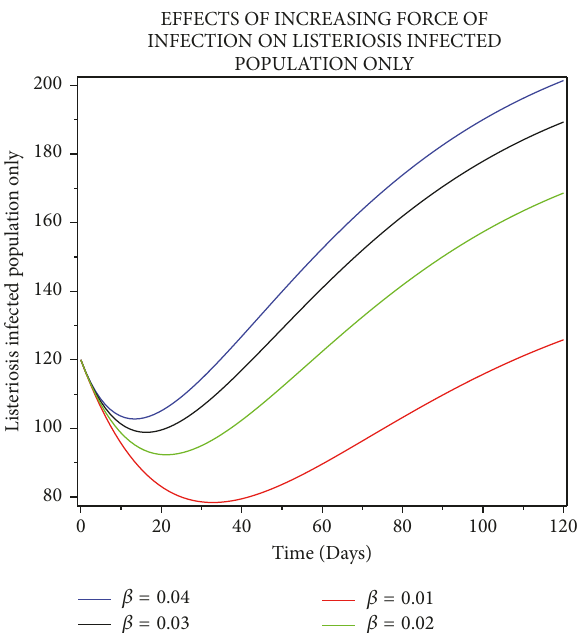
Figure 4: Simulation showing the effects of increasing the force of infection on Anthrax infected population only.